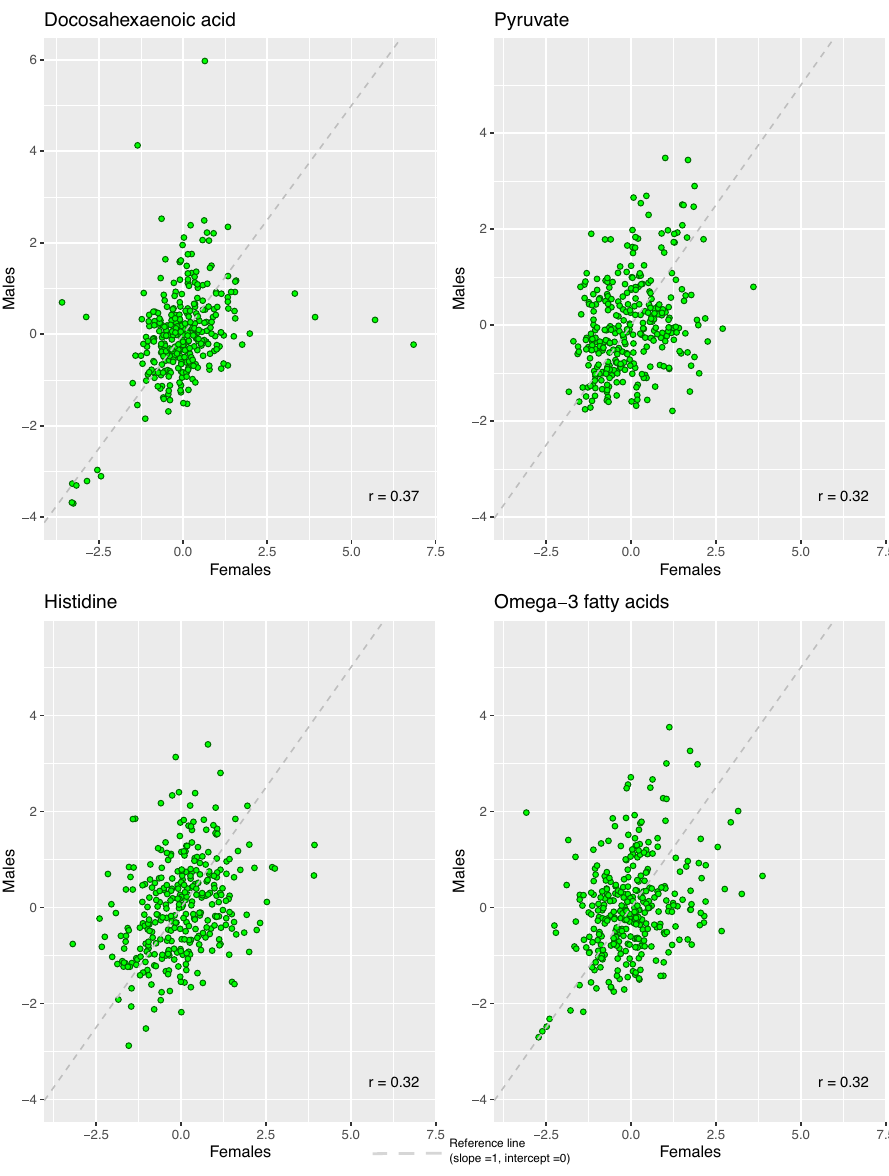
Figure 4. Multi-panel scatterplot of individual measures of metabolites in 326 women and their male partners for four selected metabolites with a within couple correlation of greater than 0.3. The green dots highlight the individual couples. The grey dashed line reflects the reference line (slope 1, intercept 0) and the red dashed line is the best line of